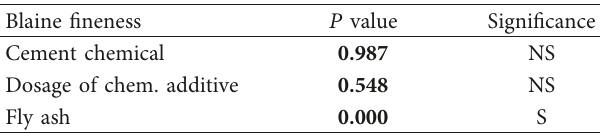
Table 3: Results of ANOVA test for Blaine fineness